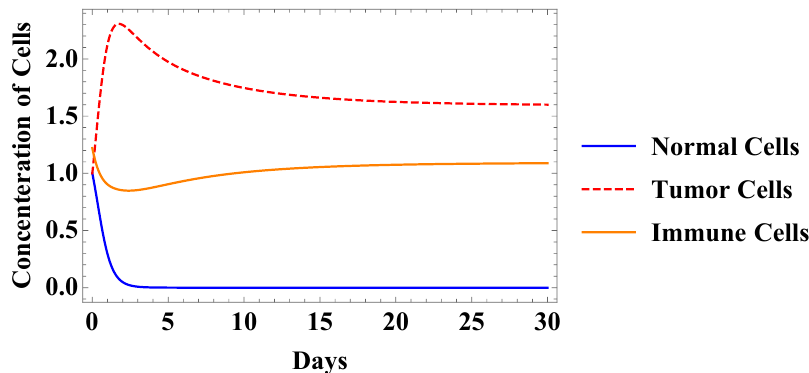
Figure 5. The cell behaviors in the NTIUNHDM, with r = 0.4312, β 1 = 2.99 ∗ 10 − 6 , η = 0.1379, γ = 0.9314, α 1 = 0.4426, α 2 = 0.4, β 2 = 1.1890, α 3 = 0.1469, σ = 0.7, δ = 0.57, µ = 0.8130, ρ = 0.2710, m = 0.8130, µ 1 = 0.3634, ρ 1 = 0.7829, and m 1 =